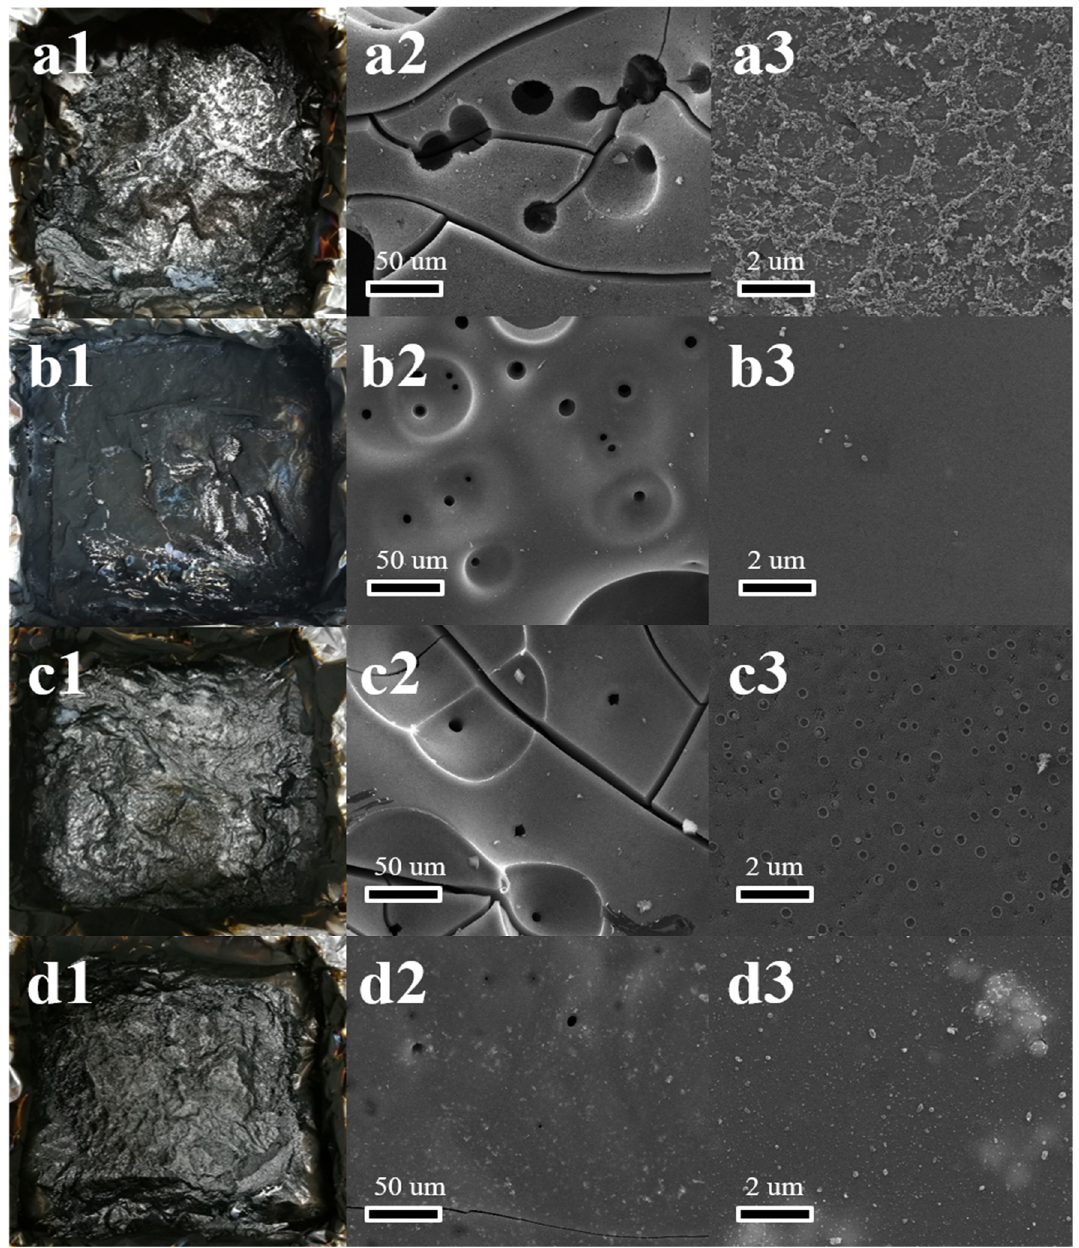
Figure 5. The images of the residues after the CC test: ( a1 , b1 , c1,d1 ) the real picture of the pure WPU, BP/WPU, BN/WPU, BP/BN/WPU, respectively; ( a2 , b2 , c2 , d2 ) SEM image of the pure WPU, BP/WPU, BN/WPU, BP/BN/WPU, respectively; ( a3 , b3 , c3 , d3 ) the enlarged SEM image of the pure WPU, BP/WPU, BN/WPU, BP/BN/WPU.